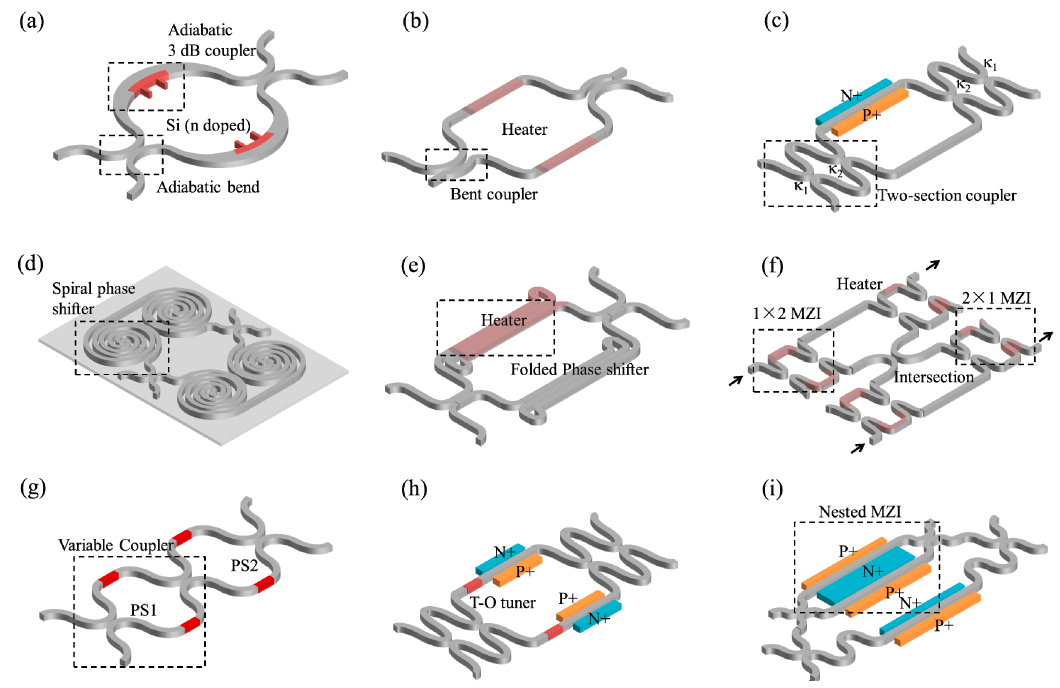
Figure 2. Schematic of various of MZI switch cells: ( a ) Adiabatic T-O MZI switch ( b ) T-O switch with bent couplers ( c ) E-O switch with two-section couplers ( d ) E-O switch with spiral phase shifter ( e ) T-O switch with folded phase shifter ( f ) T-O switch array ( g ) T-O switch with variable coupler ( h ) E-O switch with push-pull driving scheme ( i ) E-O switch with nested MZI phase shifter.